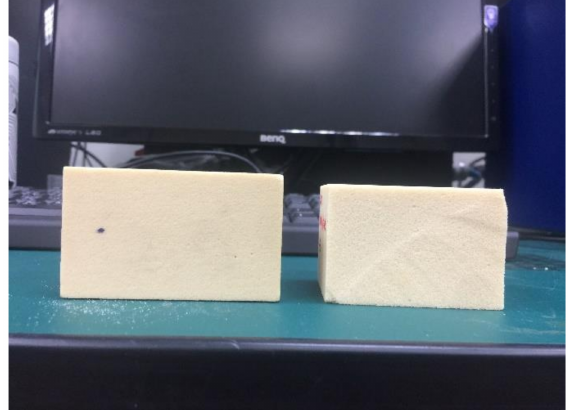
Figure 5. Two types of test blocks: 10 PCF ( right ) and 20 PCF ( left